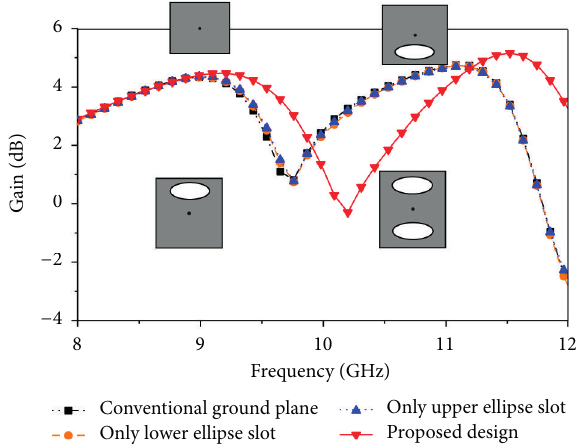
= 9 mm, 𝑊 = 4 mm, 𝐿 = 20 mm, 𝑠 𝑠 𝑔 𝑌 = 10, 8.6 ). 𝑓 , 𝑓